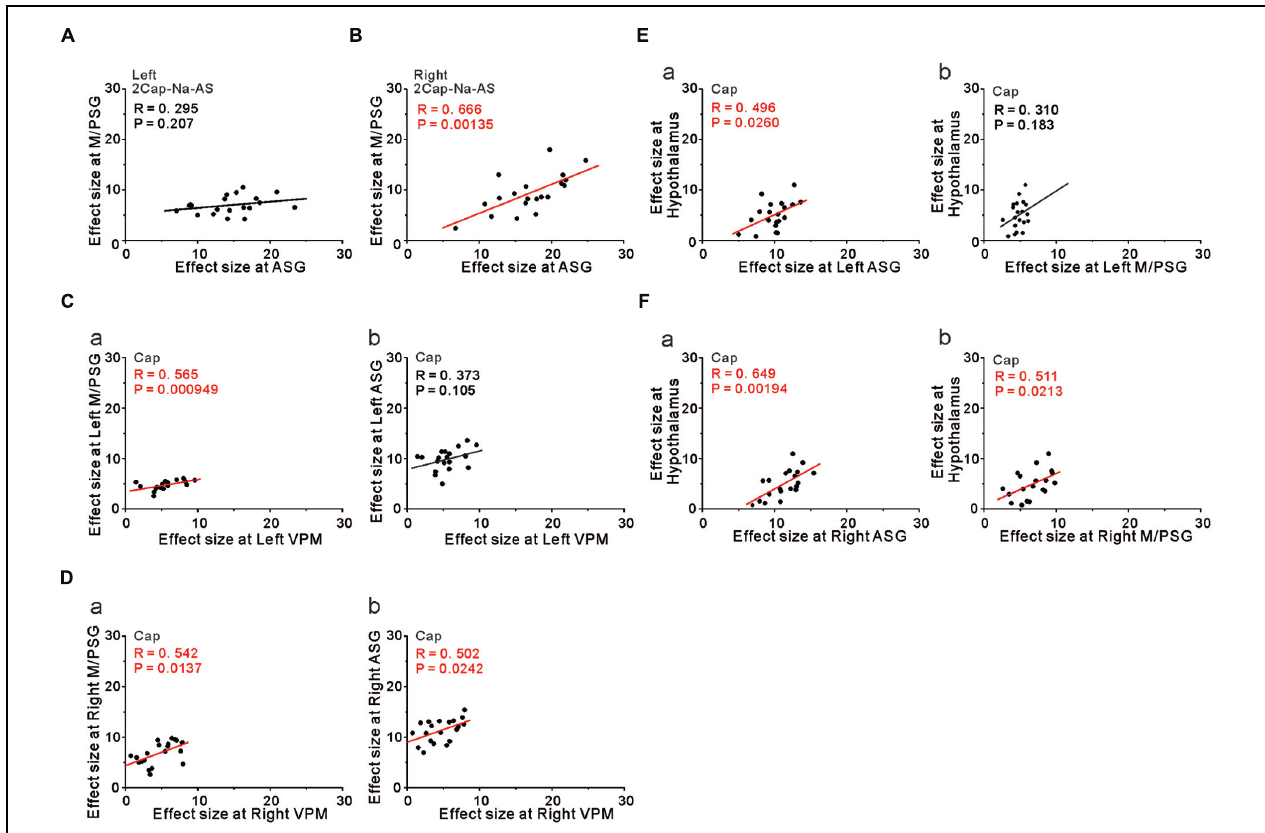
FIGURE 8 | The integration and coordination between two brain regions. (A,B) Correlation between the effect sizes at the peak coordinates in the left ASG and left M/PSG (A) and those in the right ASG and right M/PSG (B) obtained in the group analysis of the comparison [2 × Capsaicin–NaCl–AS]. (C) Correlation between the effect sizes at the peak coordinates in the left VPM and left M/PSG (a) and those in the left VPM and left ASG (b) obtained in the group analysis of the capsaicin responses. (D) Correlation between the effect sizes at the peak coordinates in the right VPM and right M/PSG (a) and those in the right VPM and right ASG (b) obtained in the group analysis of the capsaicin responses. (E) Correlation between the effect sizes at the peak coordinates in the left ASG and hypothalamus (a) and those in the left M/PSG and hypothalamus (b) obtained in the group analysis of the capsaicin responses. (F) Correlation between the effect sizes at the peak coordinates in the right ASG and hypothalamus (a) and those in the right M/PSG and hypothalamus (b) obtained in the group analysis of the capsaicin